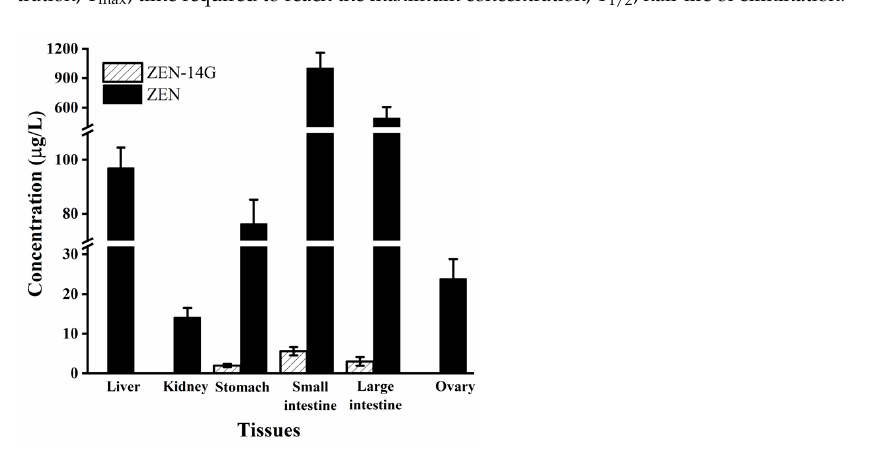
Figure 4. Tissue distribution of zearalenone-14-glucoside (ZEN-14G) and its metabolite, zearalenone (ZEN), in rats (dose of 4 mg/kg body weight, n = 3).